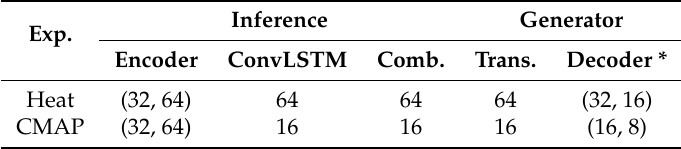
Table 3. Our model’s CNN and DCN channel specifications. () denotes multiple layers, while one value means the channel size is the same among all CNN inside the corresponding section. Heat denotes specifications during the 2D heat equation experiment and CMAP denotes specifications during the CMAP